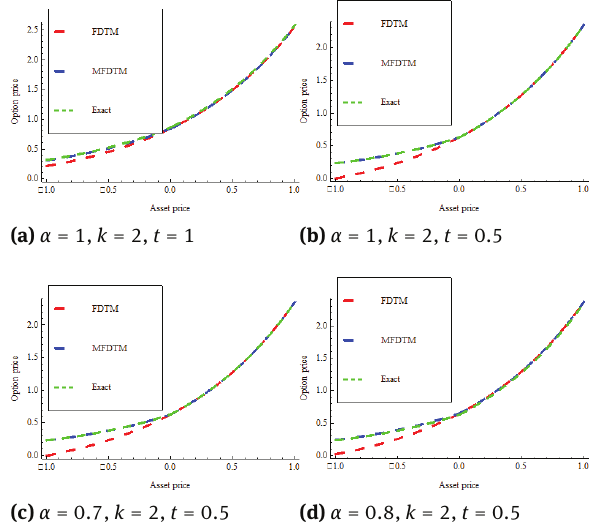
Fig. 1: Comparison of the approximate solution obtained using FDTM and MFDTM with the exact